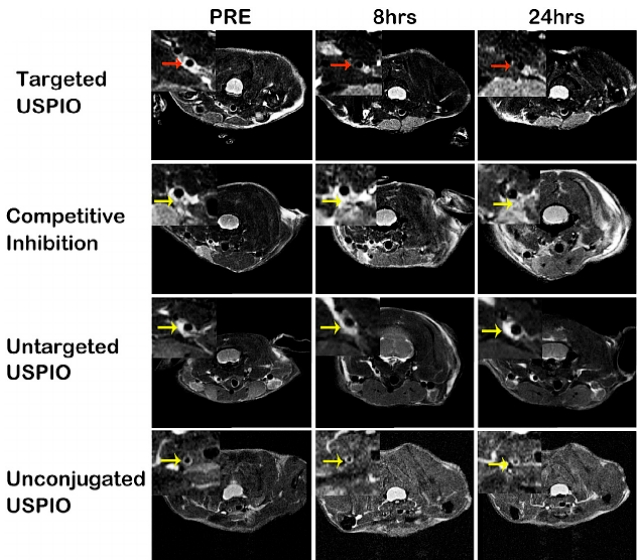
Figure 6. USPIOs MRI of ApoE − / − mice in vivo. Representative in in vivo carotid atherosclerotic lesion in ApoE − / − mice pre-, 8 and 24 hrs after administration of various USPIOs. The red arrows indicate the location of signal loss within the plaque while the yellow arrows indicate the location of carotid atherosclerotic lesions with limited rSI changes. (Reprinted from Reference [237], Crown copyright with permission from © 2014, Elsevier Ltd.).